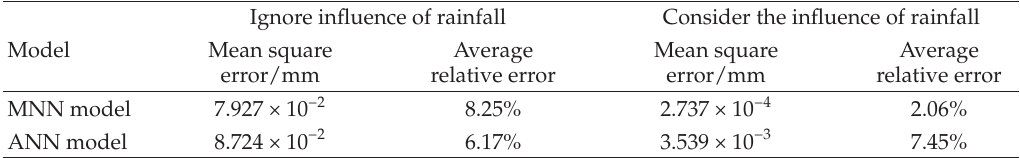
Table 1: Accuracy of